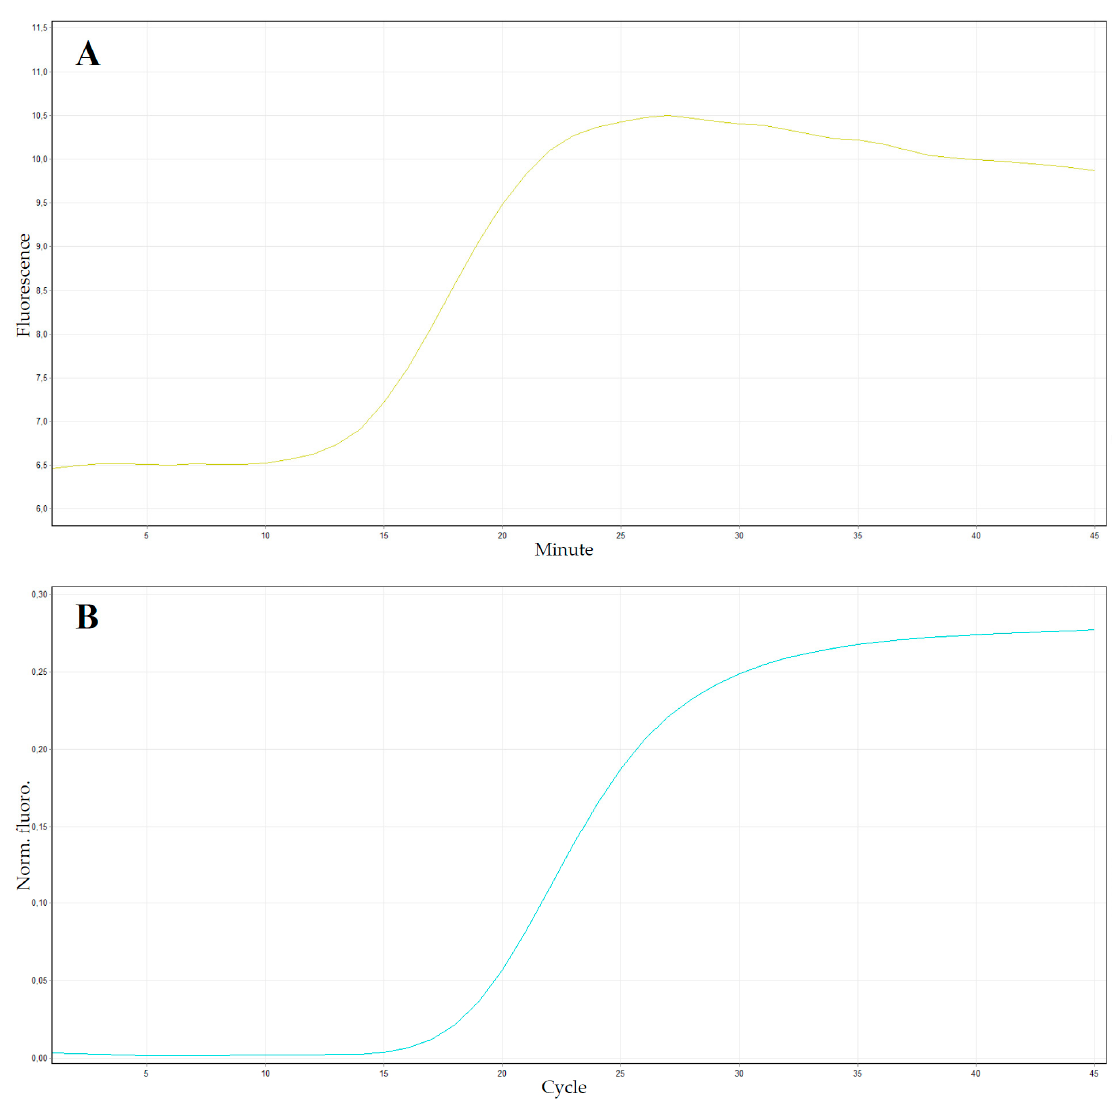
Figure 5. Result comparison between real-time LAMP and conventional real-time polymerase chain reaction (PCR). Panel ( A ) shows the LAMP amplification curve, which looks like a “hat”, while panel ( B ) shows the conventional sigmoidal real-time PCR amplification